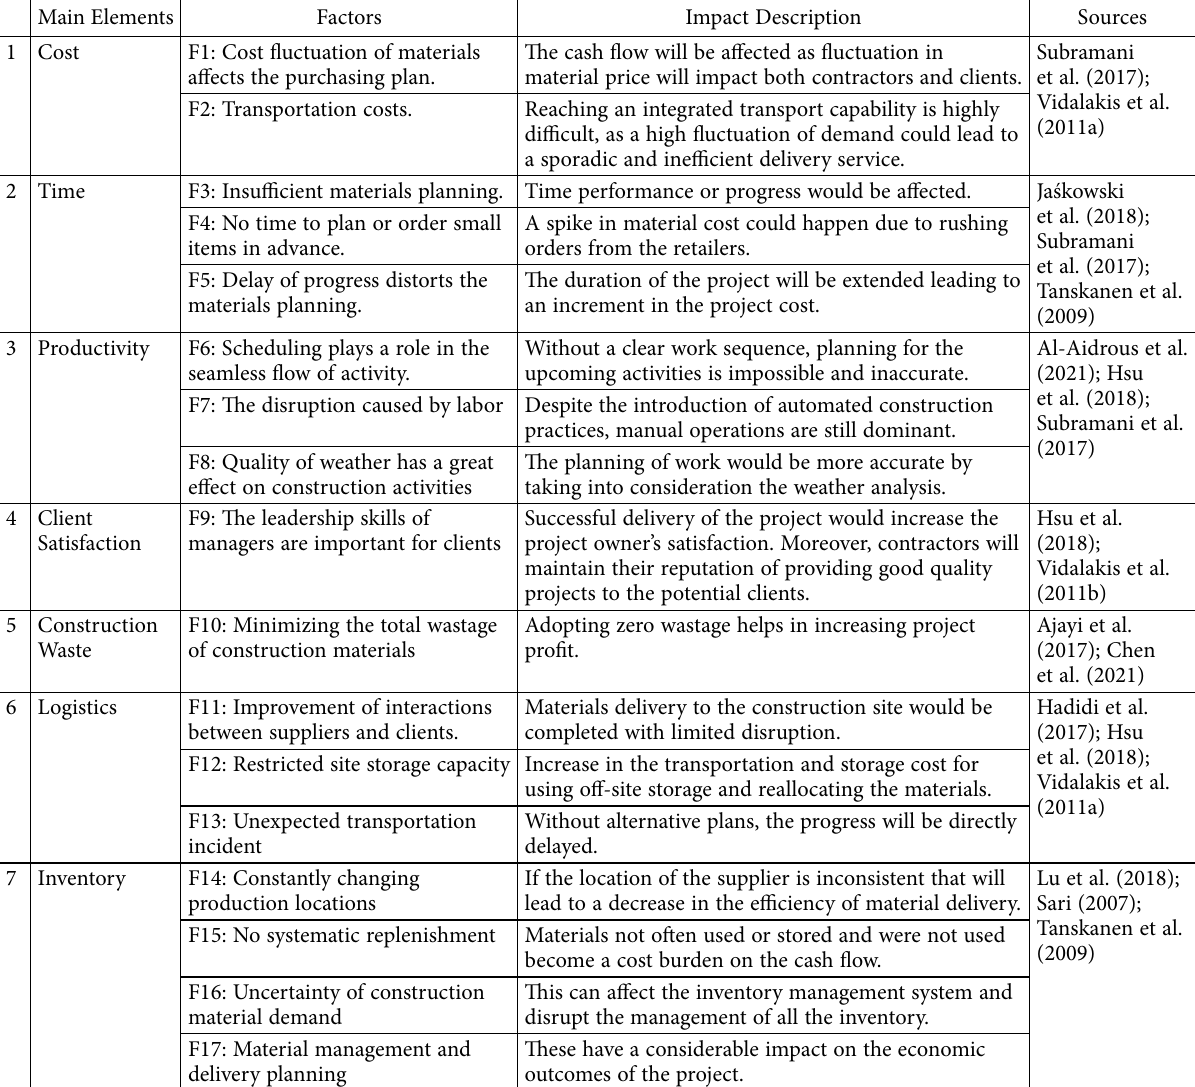
Table 1. Summary of preliminary inventory and procurement management